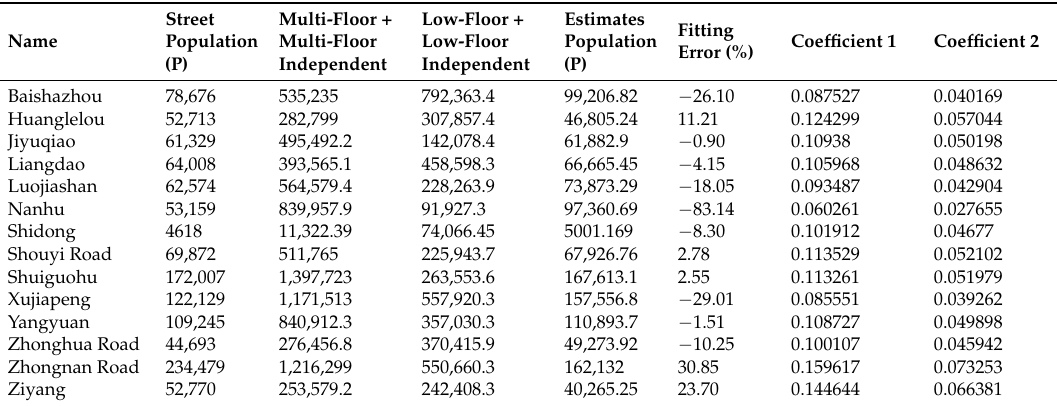
Table 3. Statistics of Corrected Coefficient Divided by Street.